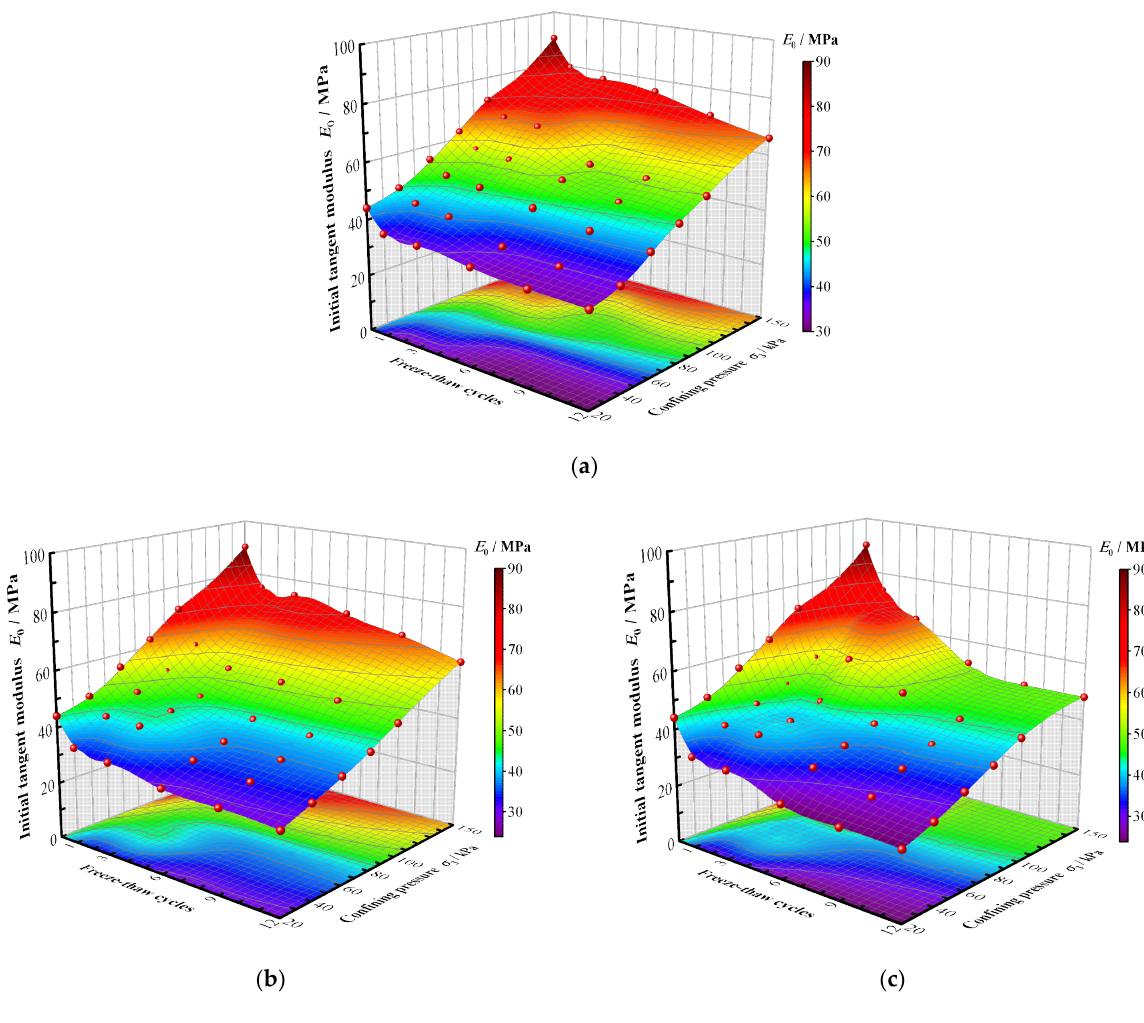
Figure 4. The initial tangent moduli of CIL under different F-T cycles and confining pressures, ( a ) The freezing condition of −5 °C, ( b ) The freezing condition of −10 °C, ( c ) The freezing condition of −15 °C. Table 3. The strength loss rates under different